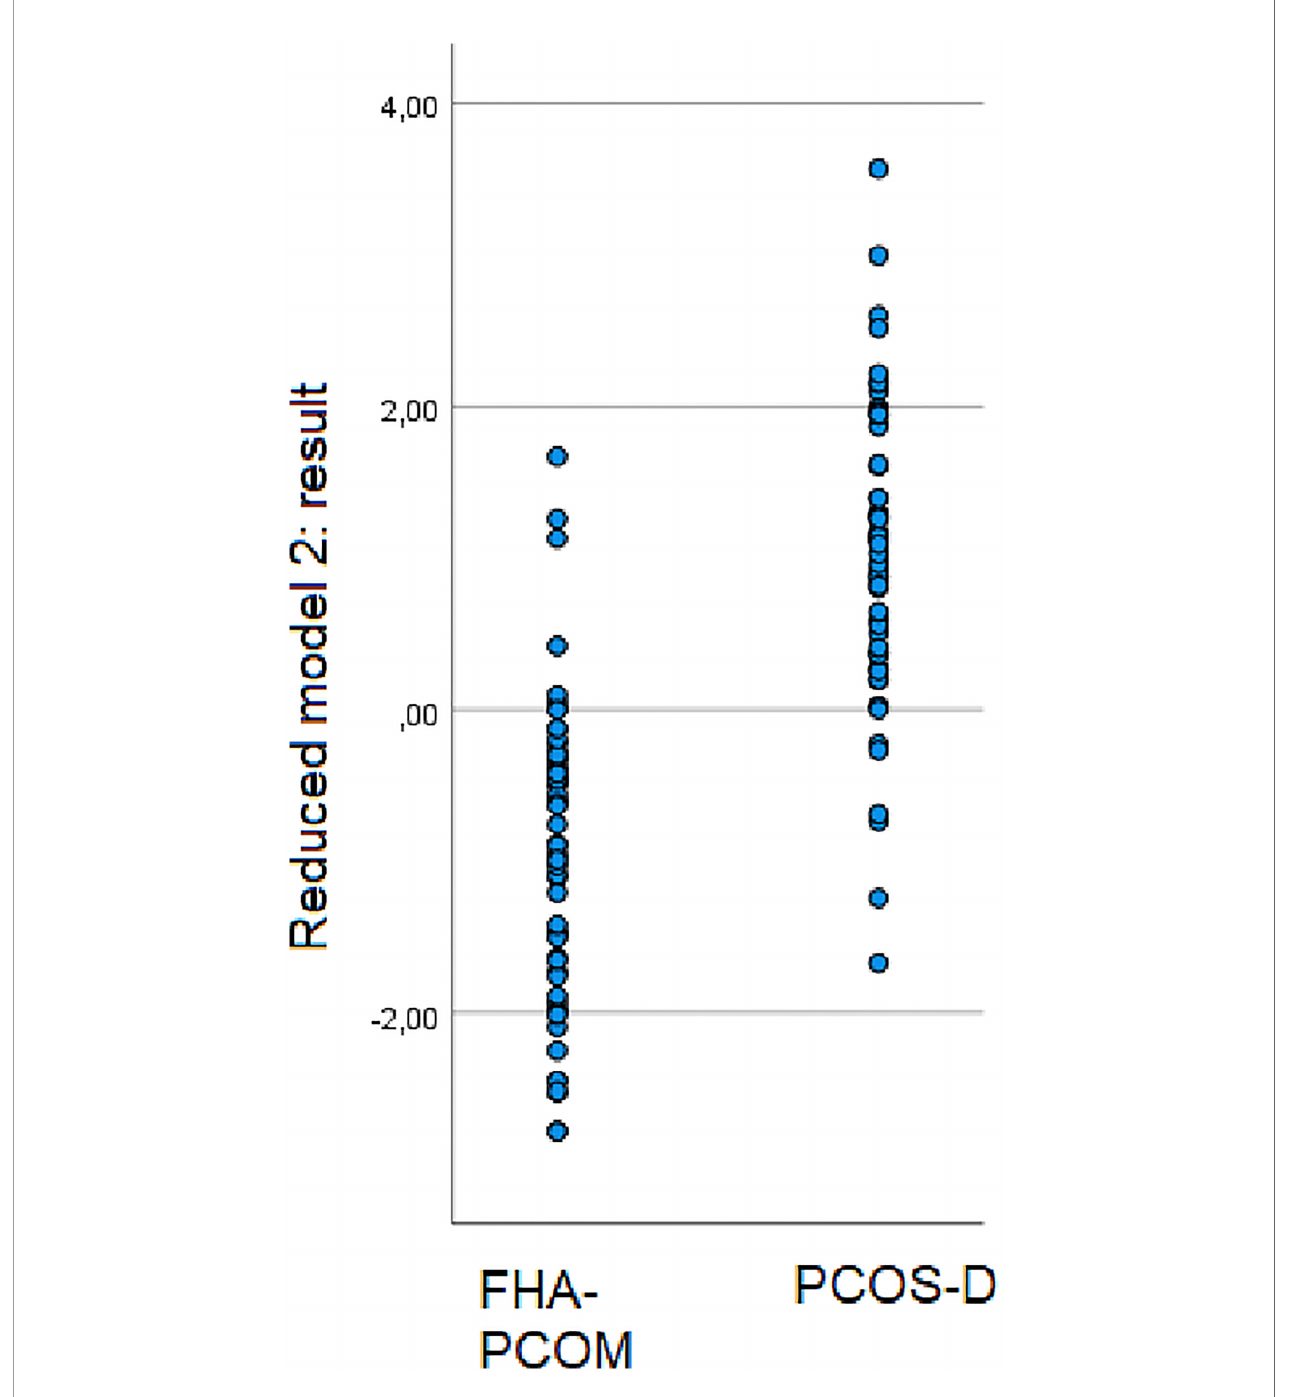
FIGURE 2 | The reduced linear discriminant analysis includes testosterone, SHBG and LH as predictive parameters for FHA-PCOM. The scatter plot shows the results of the formula used “ (7.05*testosterone ng/mL) – (0.005*SHBG nmol/L) + (0.117*LH mIU/mL) - 2.463 ” for women with FHA-PCOM and